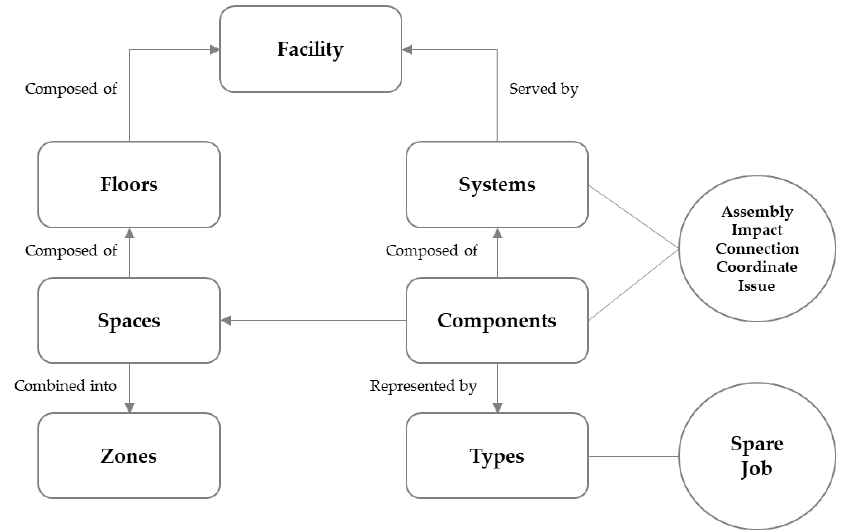
Figure 3. Model entities in a Construction Operations Building Information Exchange (COBie) object-oriented data structure.